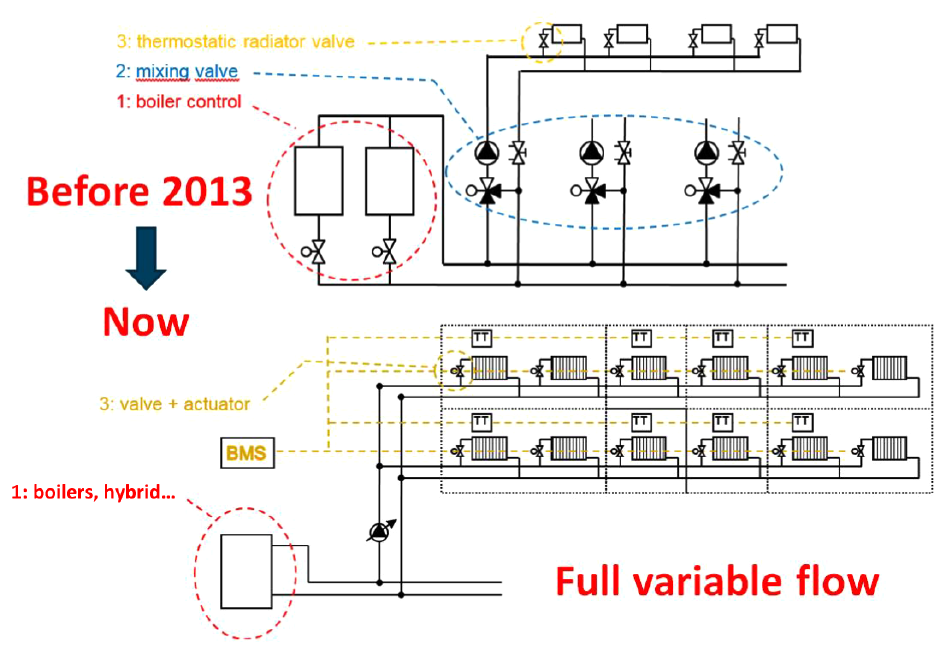
Fig. 19. – From constant flow rate to full variable